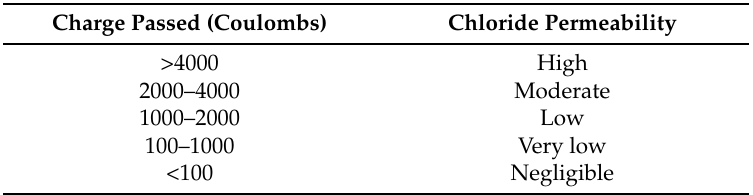
Table 6. Limit values according to ASTM C1202 [35].